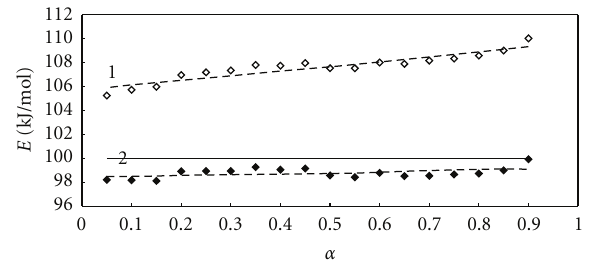
Figure 4: Degradation profiles for the array with P w / P n = 2 calculated by the Flynn-Wall-Ozawa (1) and the KAS (2) methods. Continuous horizontal line shows E value given at the simulation.